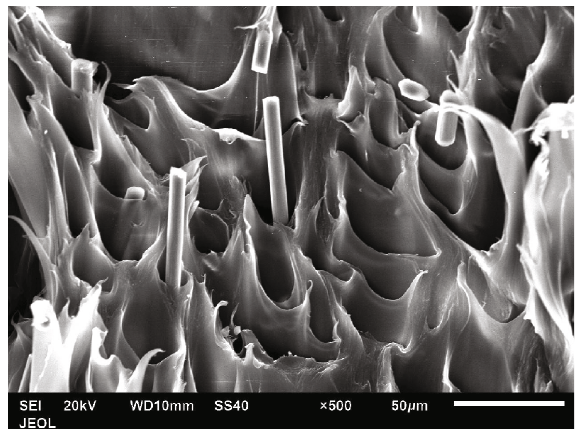
Figure 12: SEM image of fracture surface for the PP/13SCF composite (loading direction perpendicular to the fracture